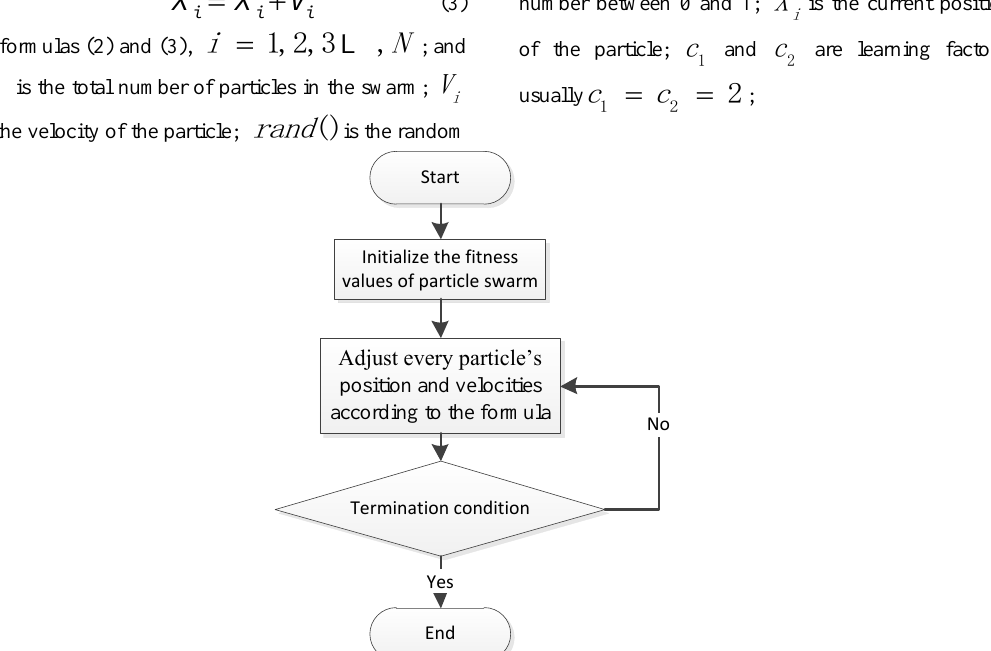
algorithm based on particle swarm optimization (PSO) algorithm. The particle swarm optimization